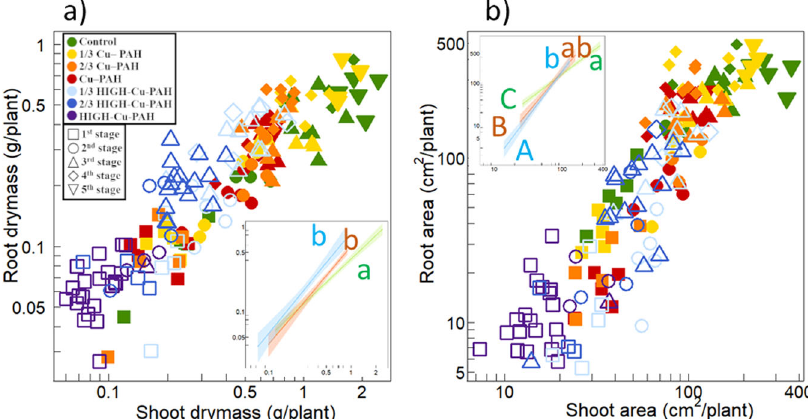
Fig. 2 In fl uence of soil treatment on the allometric relationships between root and shoot biomass and area. Symbols and colors are as in Fig. 1 (see legend in panel a ). Here, for the sake of clarity, relationships for the different soil treatments are presented in three groups in the insets of both panels (Control and 1/3 Cu-PAH soils in green; 2/3 Cu-PAH and Cu-PAH soils in red; 1/3 HIGH-Cu-PAH and 2/3 HIGH-Cu-PAH soils in blue). Corresponding relationships are similar for both soil treatments of the same group (Supplementary Table 2). Fitted relationships (lines) and 95% con fi dence envelopes (shaded areas) are shown except for plants from the HIGH-Cu-PAH soil, because they did not grow. Lowercase letters indicate difference in α allometric coef fi cient ( P < 0.05). Uppercase letters indicate difference in β proportionality coef fi